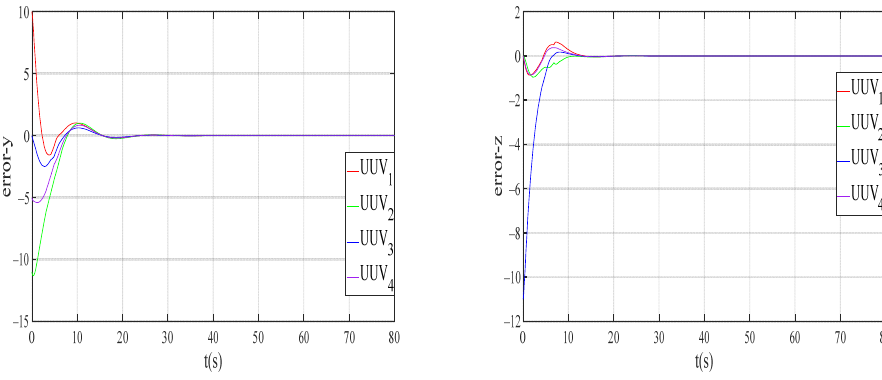
Figure 11. Position errors of UUVs in y and z directions.